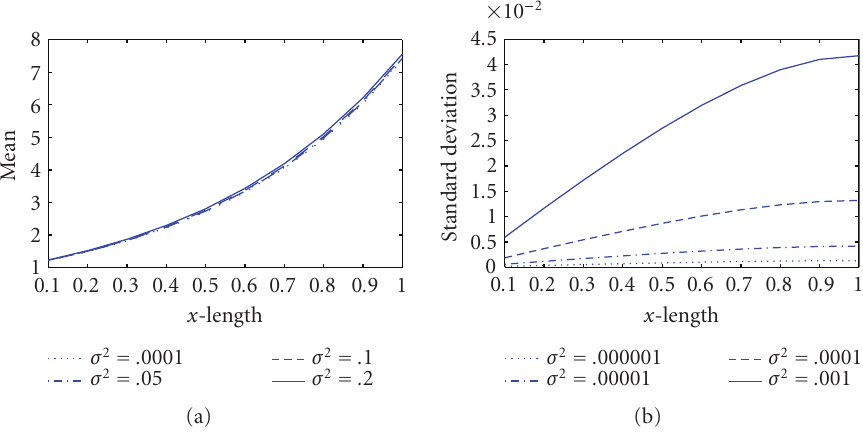
Figure 6.4. The e ff ect of σ 2 on the solution moments at stochastic heat capacity c . (a) E ff ect of σ 2 on the mean of solution at t = 1second. (b) E ff ect of σ 2 on SD of the solution at t = 1second. From Figures 6.3 and 6.4, the variation of σ 2 is more e ff ective on standard deviation than the mean of the solution